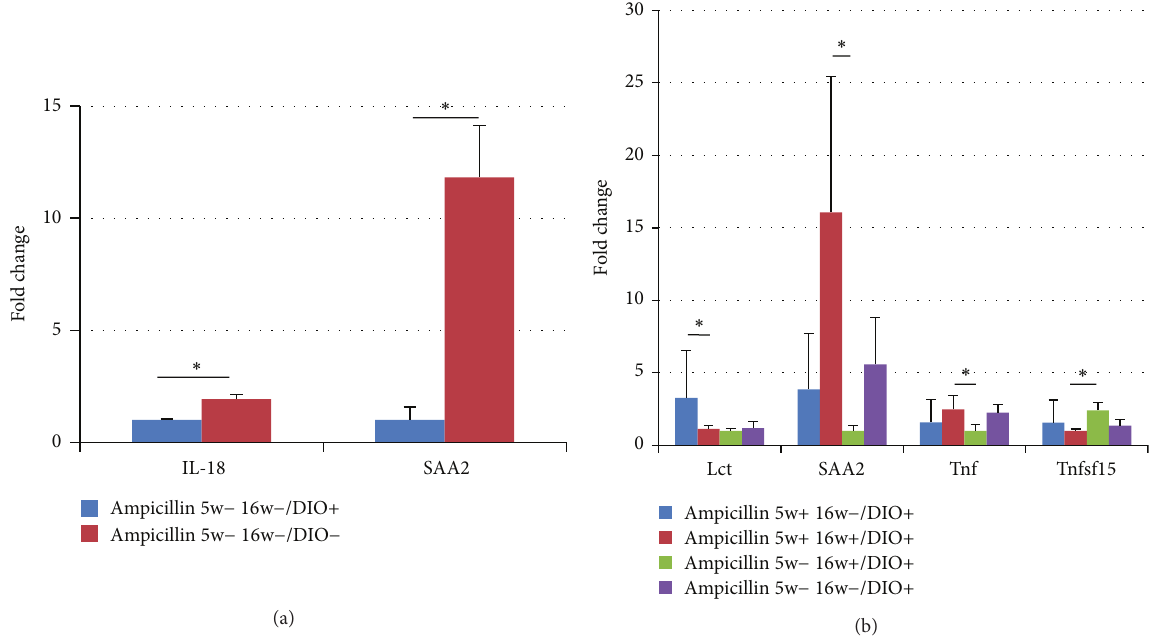
Figure 6: Significant differences in ileum mRNA expression as revealed by qPCR in diet-induced obese C57BL/6mice treated or not treated with Ampicillin from birth and until five weeks of age (1A; Ampicillin 5w+ 16w − /DIO+), from 12 to 16 weeks of age (2A; Ampicillin 5w − 16w+/DIO+), at both points in time (1B; Ampicillin 5w+ 16w+/DIO+), or not at all (2B; Ampicillin 5w − 16w − /DIO+), as well as low-fat fed control mice (3; Ampicillin 5w − 16w − /DIO − ). Interleukin 18 (IL 18), Lactase (Lct), serum amyloid A (Saa2), tumor necrosis factor (Tnf), Tumor necrosis factor ligand superfamily 15 (Tnfsf15). (a): SAA ( 𝑃 = 0.0012 ), IL-18 ( 𝑃 = 0.0014 ). (b): Lct ( 𝑃 = 0.044 ), Tnf ( 𝑃 = 0.029 ), SAA ( 𝑃 = 0.032 ), ∗∗ Tnfsf15 ( 𝑃 = 0.002